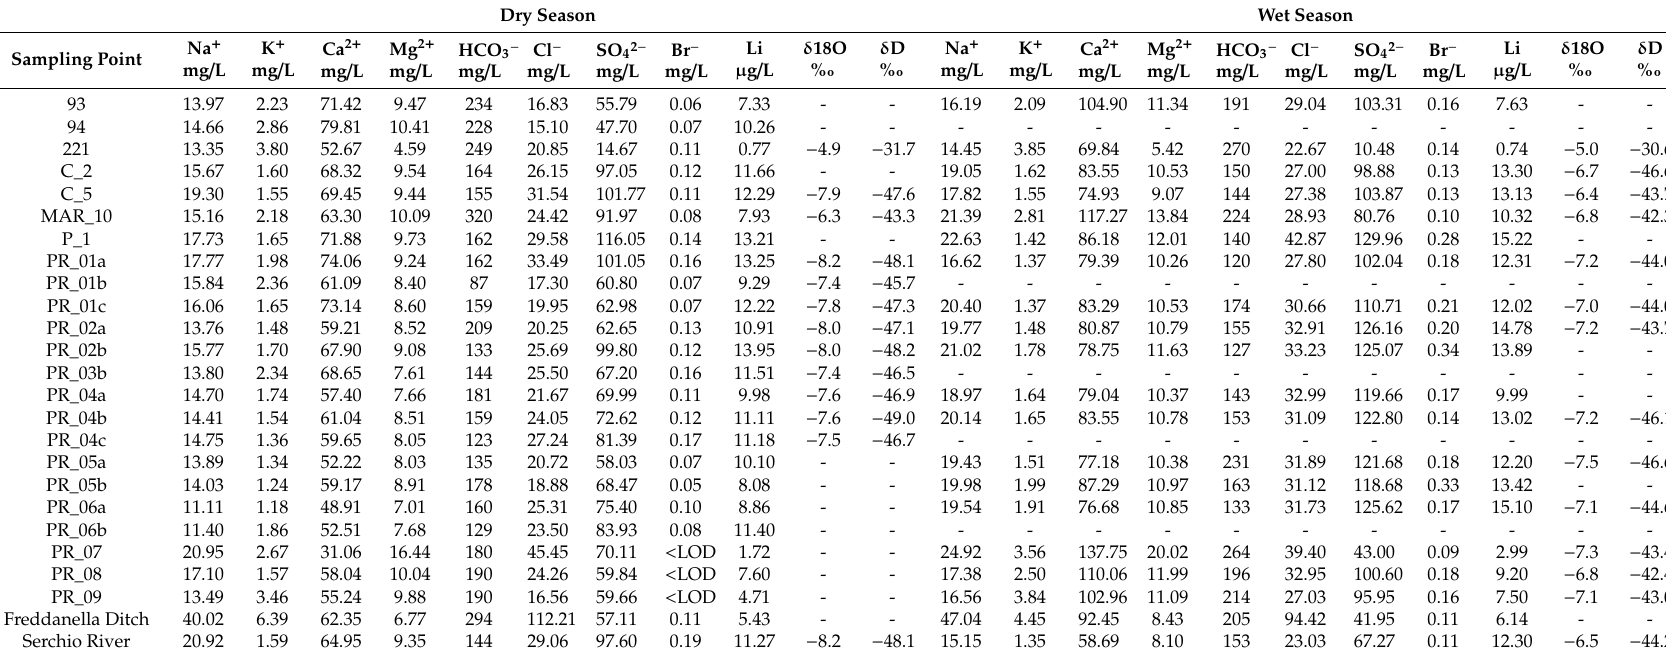
Table 3. Average values during dry and wet season of the presented